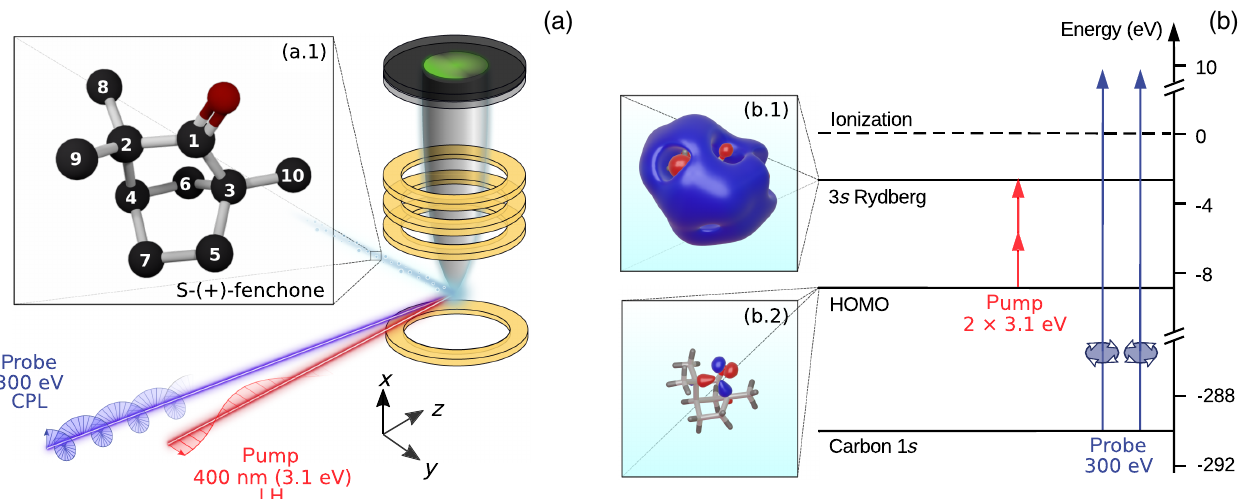
FIG. 1. (a) Experimental setup. The circularly polarized XUV probe (CPL) and the visible pump with linear horizontal (LH) polarization are focused quasicollinearly in the molecular beam of S-(+)-fenchone enantiomers. (a.1) 3D representation of the S-(+)-fenchone, where only carbon (black) and oxygen (red) atoms are shown, while hydrogen atoms are hidden for the sake of clarity. Carbon atoms are labeled from 1 to 10. (b) Simplified energy level diagram of the excitation scheme. (b.1) 3D representation of the LUMO þ 1 orbital ( 3 s Rydberg state). (b.2) 3D representation of the HOMO orbital. Representations (a.1), (b.1), and (b.2) share the same molecular